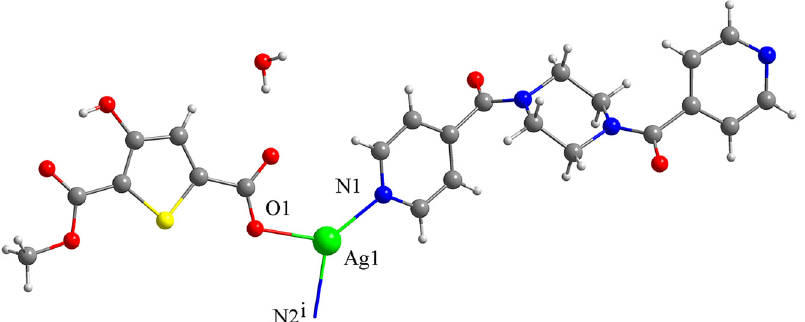
Table  : Data collection and